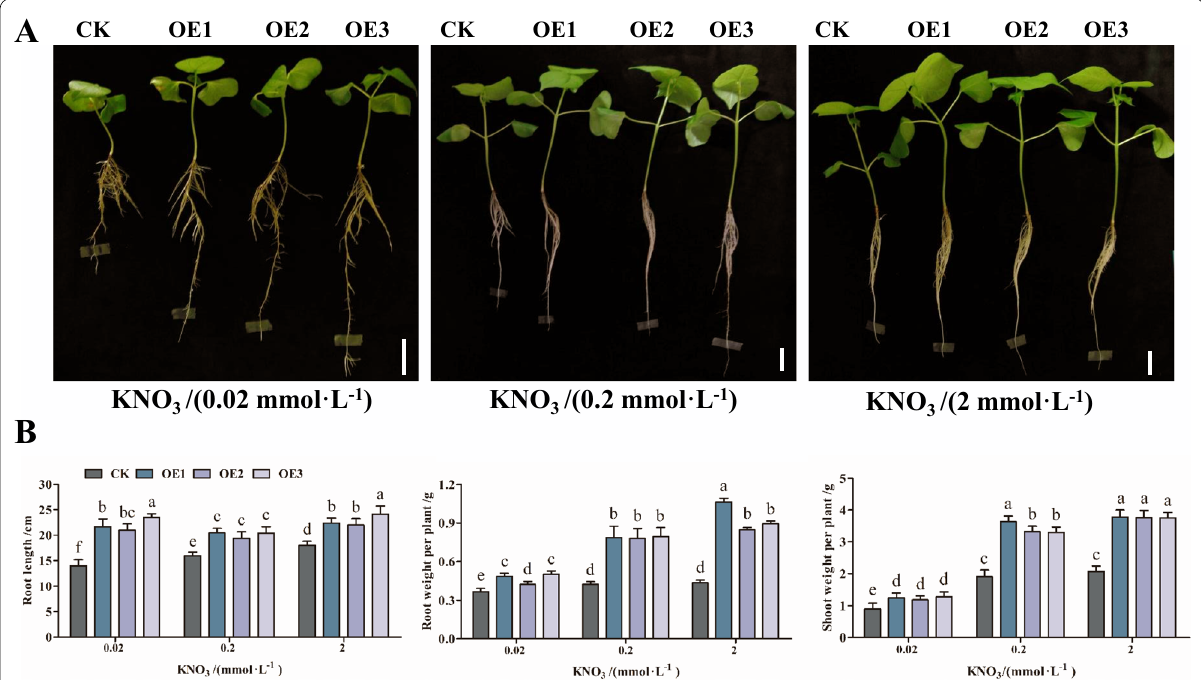
Fig. 1 AtNLP7 improved the growth of cotton seedling in hydroponic culture with different N levels. A Seedling of CK and transgenic cotton grown under different N levels. A representative seedling is shown for each line. Bar (n 3 replicates, 16 plants per replicate). Letters denote significant differences ( P < 0.05) from Duncan’s multiple range tests =